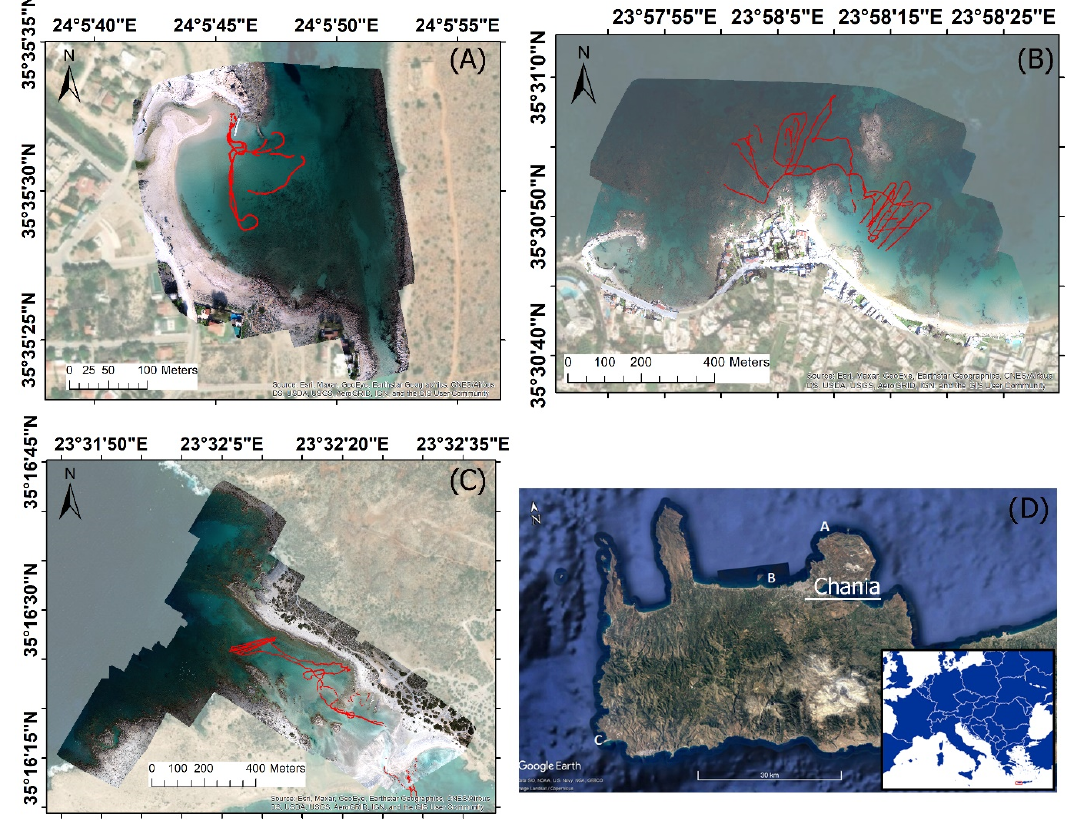
Figure 1. Overview of the study areas: ( A ) Stavros bay, ( B ) Kalamaki beach, ( C ) Elafonisi beach, ( D ) Crete island (west part). Red dots indicate USV track lines.